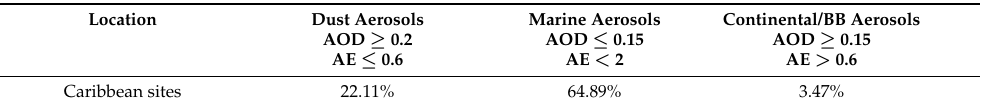
Figure 4. AE (440–870 nm) versus AOD (440 nm) distribution for daily data from 1996 to 2021 for Caribbean sites located in PR, GPE and BAR. N represents the data point number. Table 3. Percentage of daily case meeting dust, marine, and continental/BB particles criteria for Caribbean sites located in PR, GPE, and BAR between 1996 and